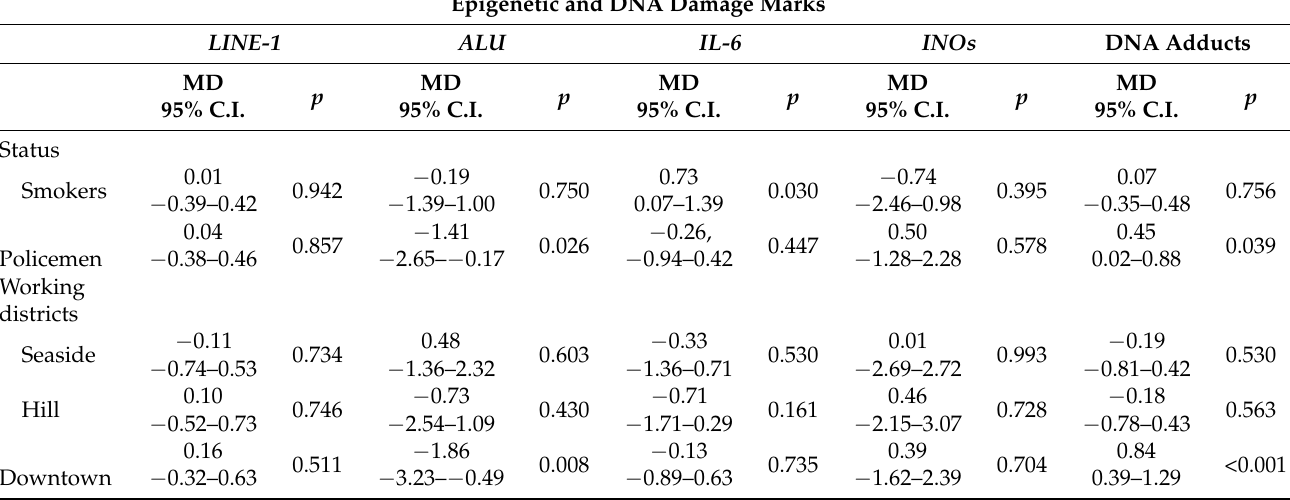
Table 3. Means Difference (MD) with respect to reference level of each variable and 95% Confidence Intervals (C.I.) of DNA methylation in the repetitive elements of the Long Interspersed Nuclear Element-1 ( LINE-1 ) and ALU and in the promoter domains of the interleukin-6 ( IL-6) and the inducible nitric oxide synthase (i NOS) genes and MD and 95% C.I. of bulky DNA adducts according to smoking habit, exposure status, and three working suburbs of Genoa, Italy (seaside, hill, and downtown). Epigenetic and DNA Damage